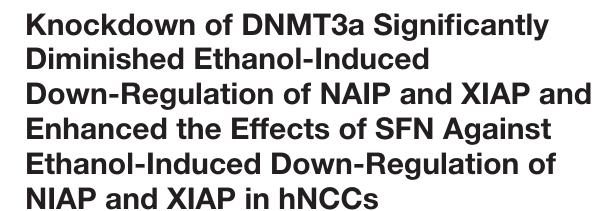
Frontiers in Cell and Developmental Biology |